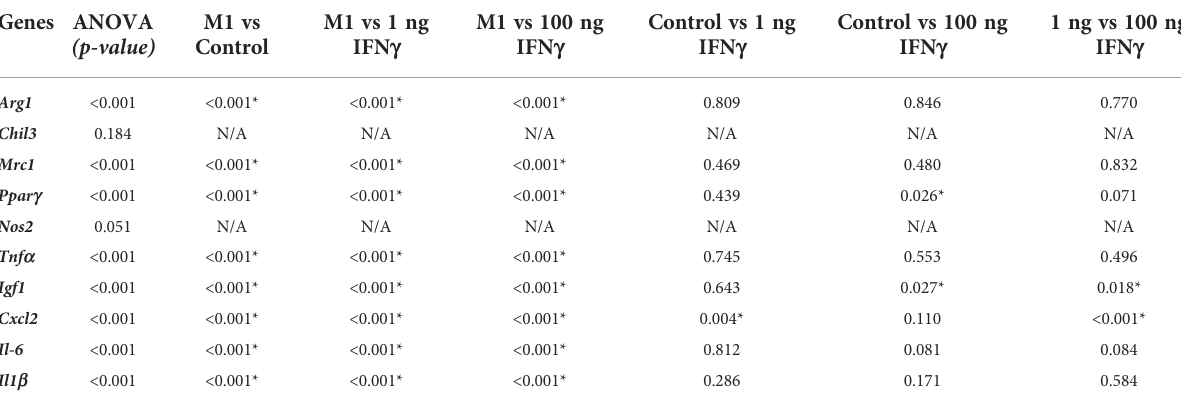
TABLE 5 Pairwise comparison between all treatment conditions. Holm-Sidak Pairwise Comparison (Between Groups) (p-value) Genes ANOVA